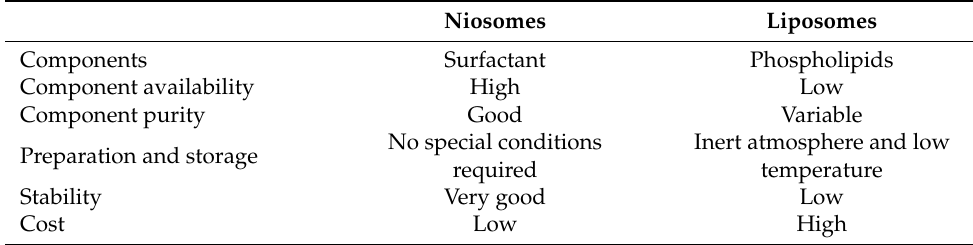
Table 3. Niosomes versus liposomes as gene/drug carriers.